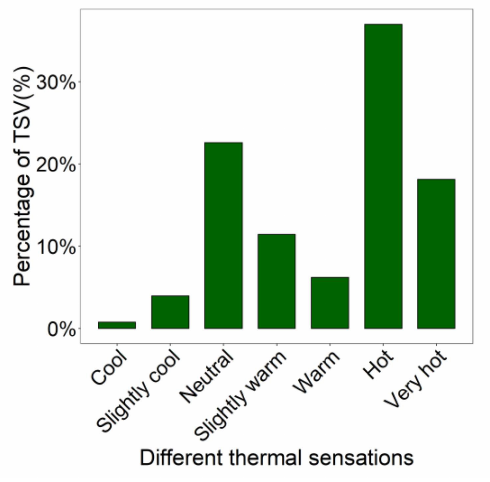
Figure 3. Thermal sensation